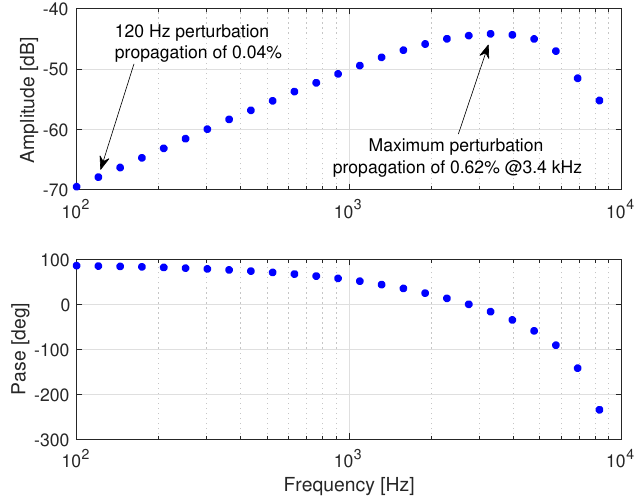
Figure 14. Perturbations mitigation in the closed-loop